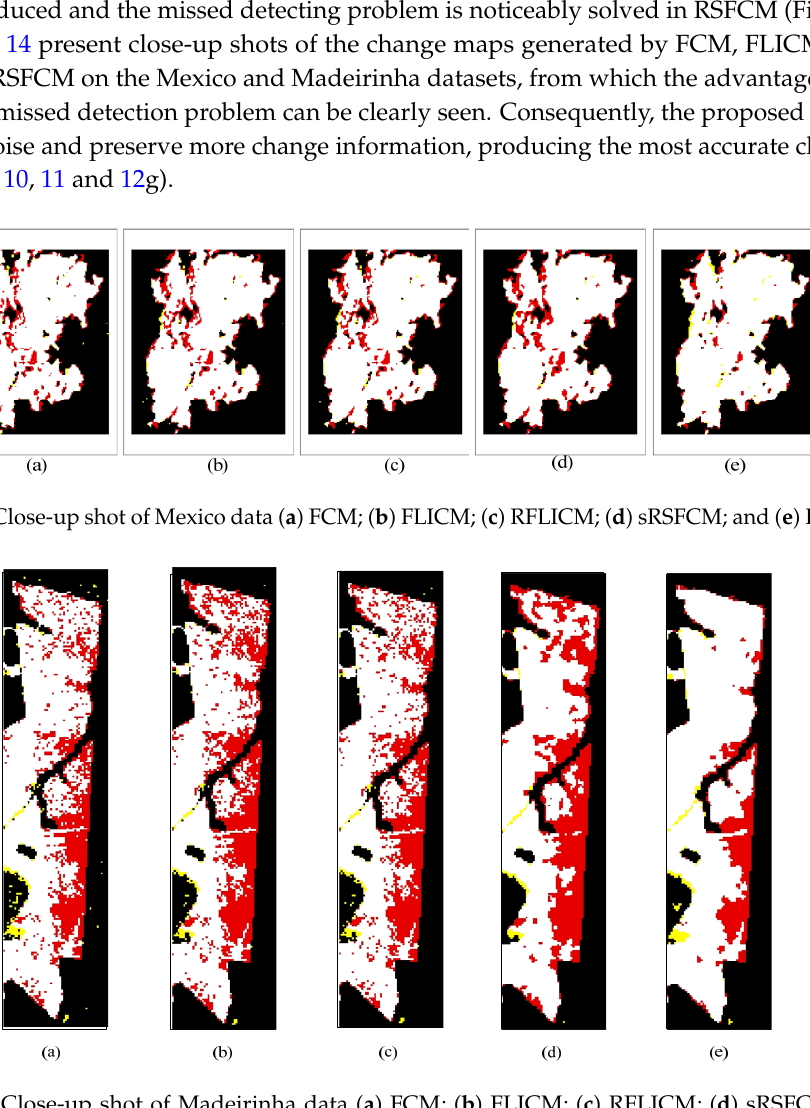
Figure 14. Close-up shot of Madeirinha data ( a ) FCM; ( b ) FLICM; ( c ) RFLICM; ( d ) sRSFCM; and ( e ) RSFCM. ( e )